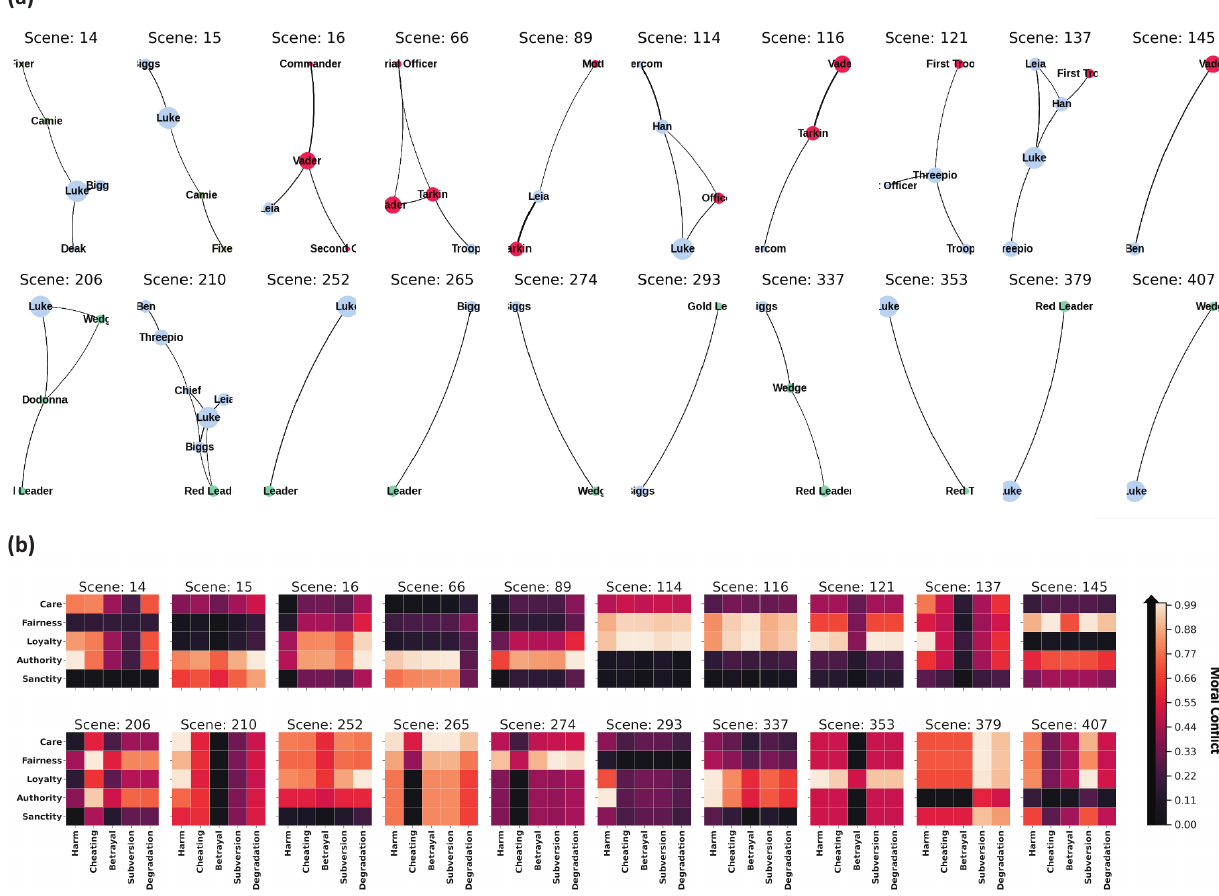
Figure 5. Moral conflict in Star Wars Episode IV : (a) Cross-module scenes and character interaction networks; (b) Moral conflict matrices. Source: